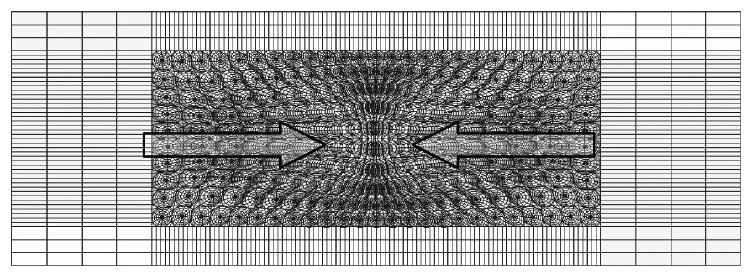
Fig. 43. EIDL 3rd mode – 908 Hz – in plane contradictory horizontal